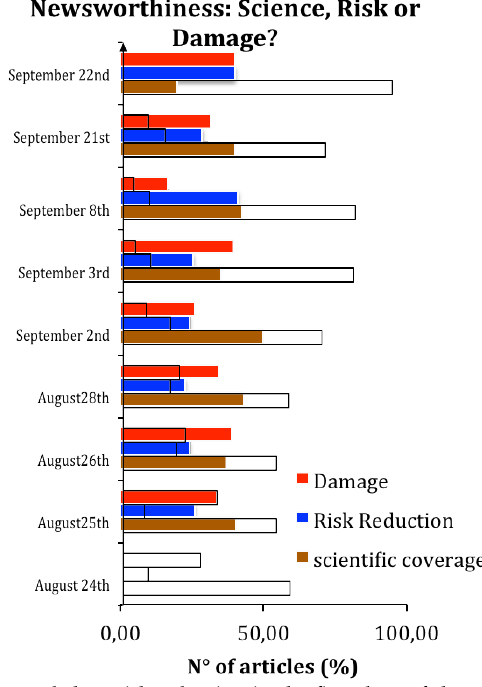
Figure 3. The newsworthiness along time is shown.